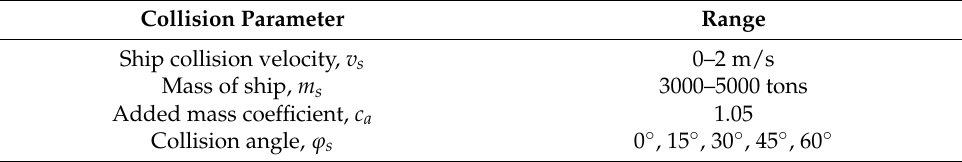
Figure 4. Diagram of ship collision angle. Table 1. The ranges of collision parameters.